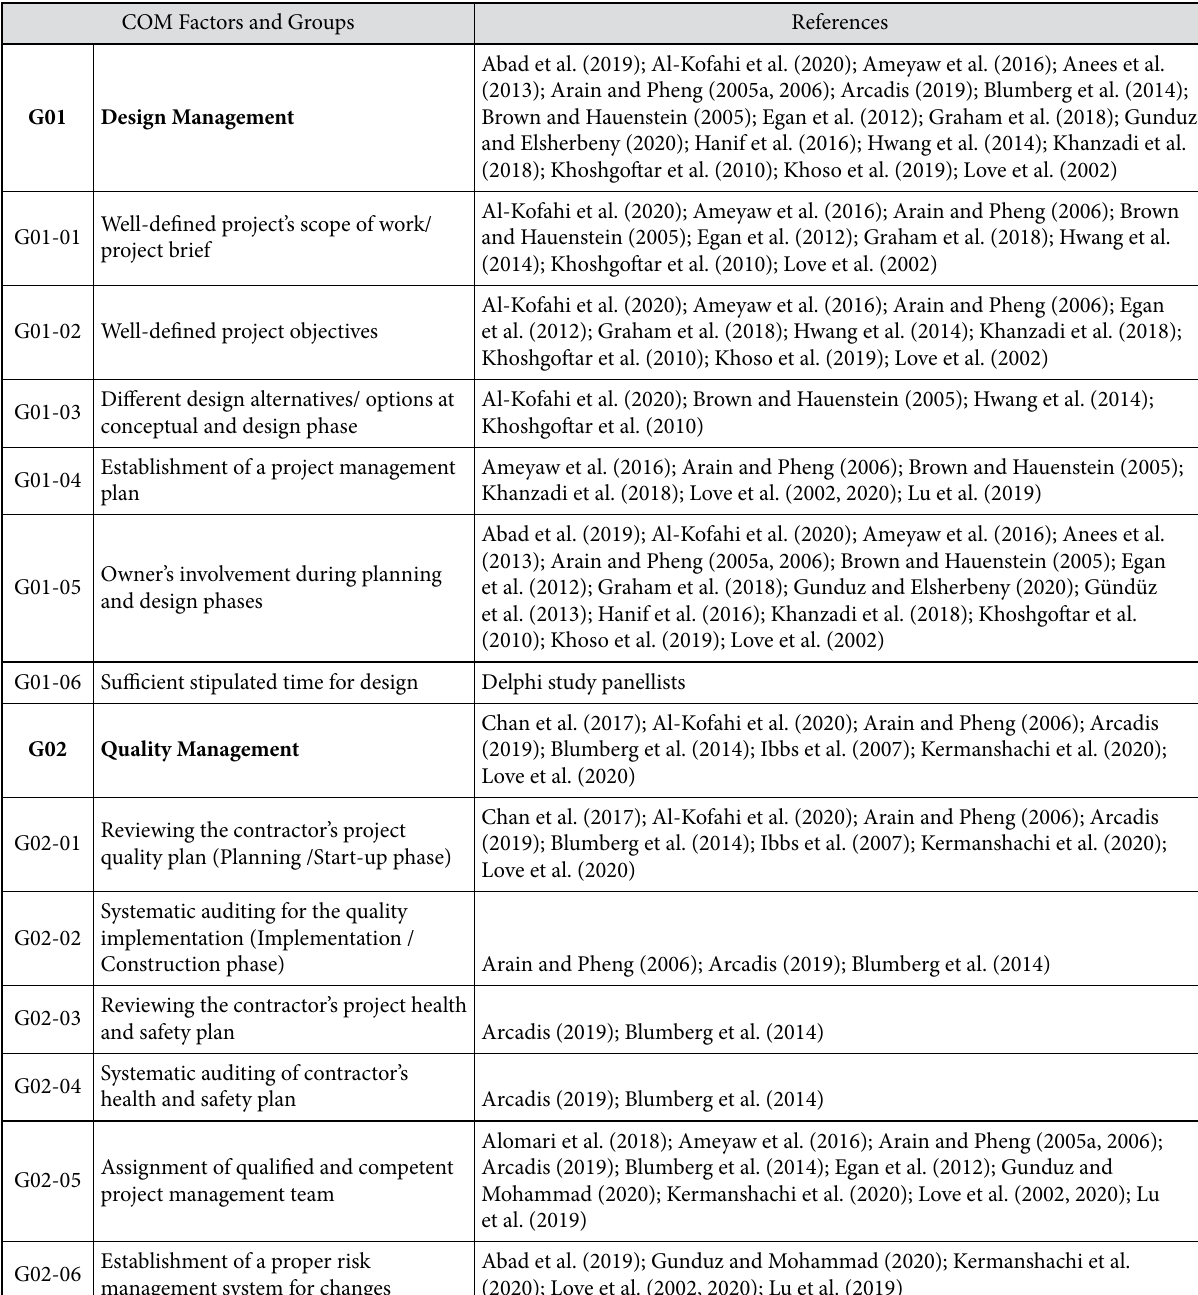
Table 1. Change orders management groups, factors and reference number of cited research paper COM Factors and